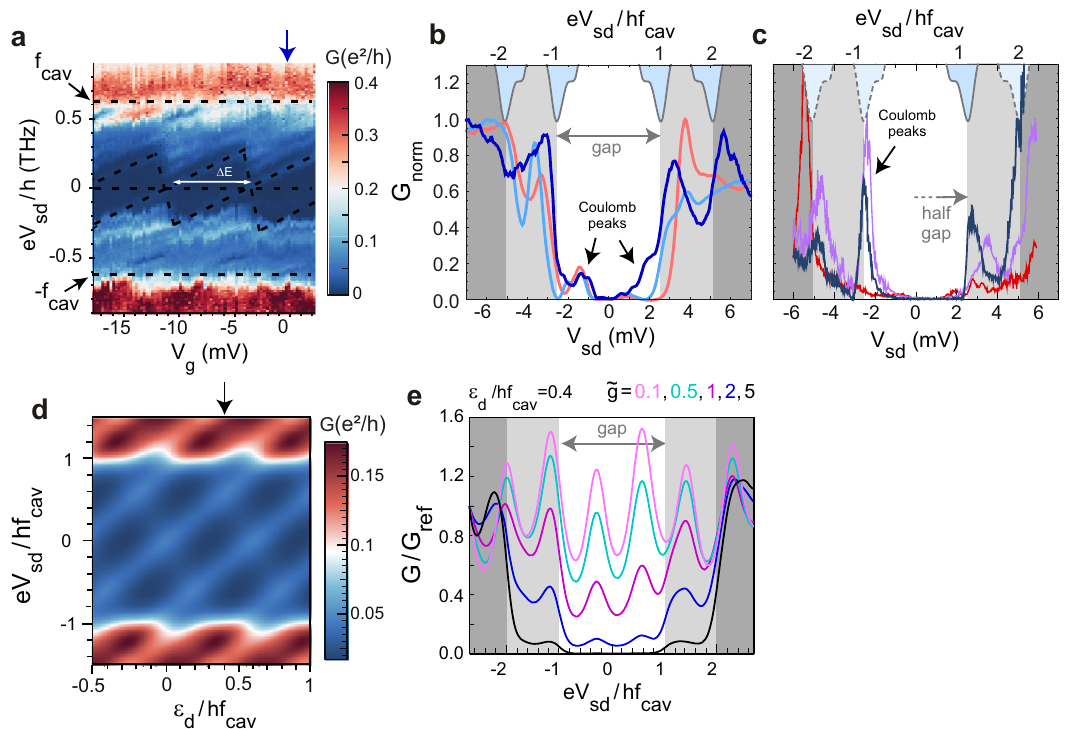
Fig. 3 Terahertz gap in the dc-transport of the devices. a Conductance G map of device A as a function of V g and V sd . Coulomb diamonds are visible in the map. They appear inside the region highlighted by black dashed lines at the cavity frequency. The blue vertical arrow indicates the cut represented in panel ( b ). b Normalised conductance G as a function of bias V sd for several gate voltages for samples A and B. The dark blue line is for sample A, Vg = − 0.25 mV, the light blue line is for sample B, Vg = − 8.90 mV, and the orange line is for sample B, Vg = − 11.3 mV. The topmost (inverted) gray curves are the LC- mode resonance centered at ± f cav and ± 2 f cav . c Normalised conductance G as a function of bias V sd for several gate voltages for sample C. The dark blue line is for Vg = 42 mV, the pink line is for Vg = 47.5 mV and the red line is for Vg = 69.5 mV. d Colorscale plot of the theoretical conductance map reproducing qualitatively that of panel ( a ). e Linear cut of the conductance as predicted from theory and showing the gap edge at ± f cav and the two-photon conductance step at ± 2 f cav observed for sample A (see parameters in the methods), for increasing dimensionless coupling strength ~ g